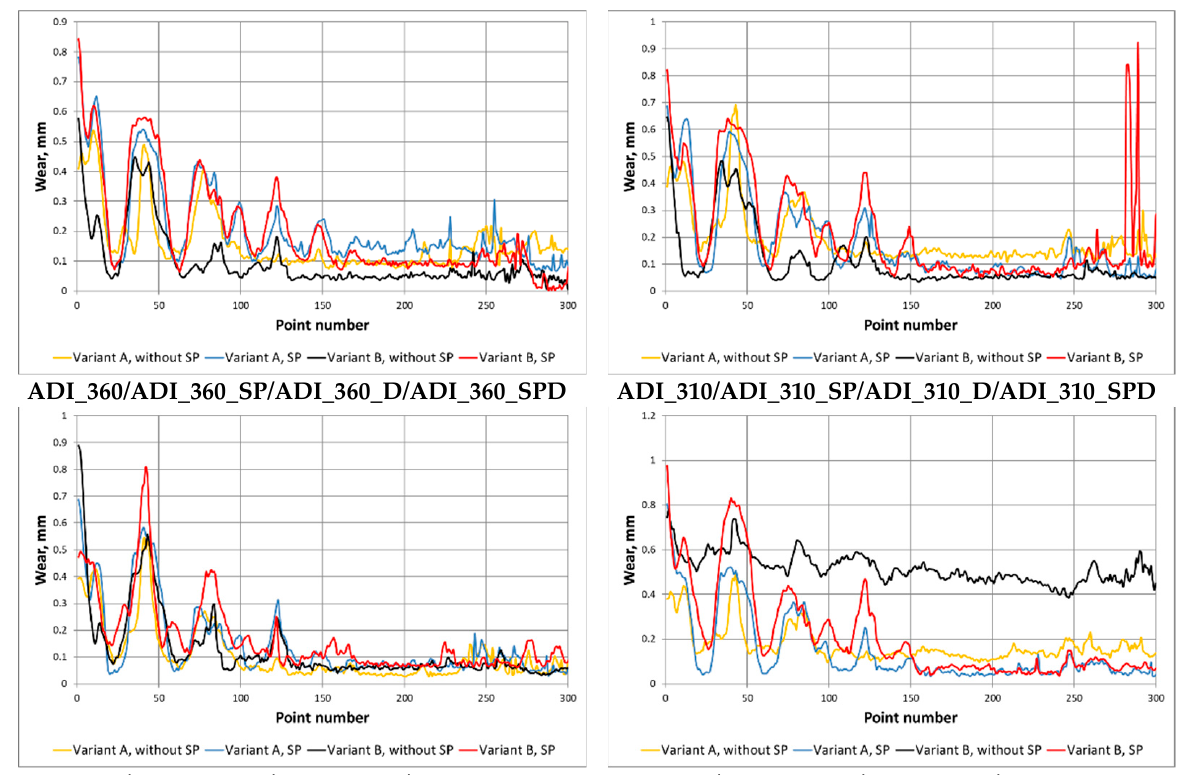
Figure 11. Waveforms of the averaged wear δ i_AVG as a function of the position in the measuring path, determined for the considered ADI.